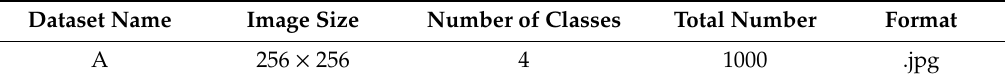
Figure 8. Some examples of data enhancement. ( a ) Origin image; ( b ) randomly crop; ( c ) change the image contrast; and ( d ) add noise. Table 2. Classification and object detection Table 2. Classification and object detection datasets.